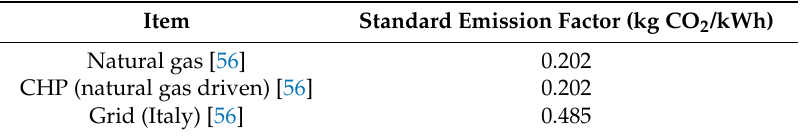
Table 5. Emission factor [56,57].